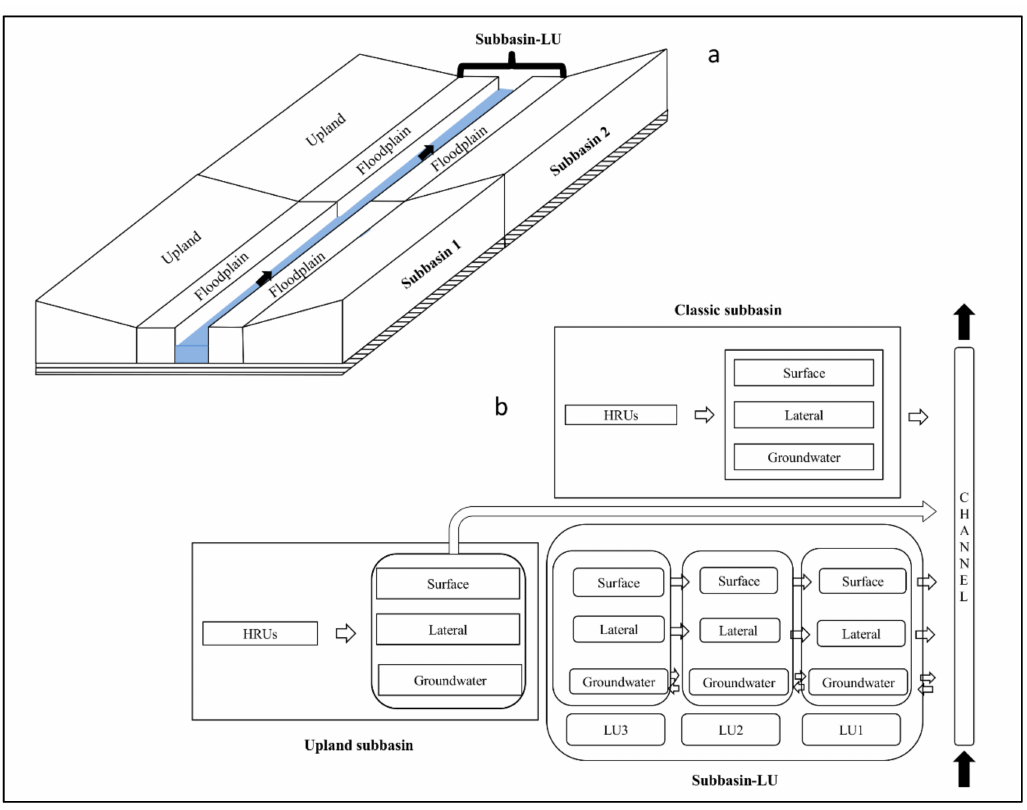
Figure 1. The hydrological processes of the SWAT-LUD model. ( a ) The location of the subbasin-LU; ( b ) the hydrological processes in the classic subbasin, the upland subbasin, and the subbasin-LU (SL). HSU = hydrologic response unit; LU = landscape unit; LU3 = the divide; LU2 = the hillslope; and LU1 = the valley